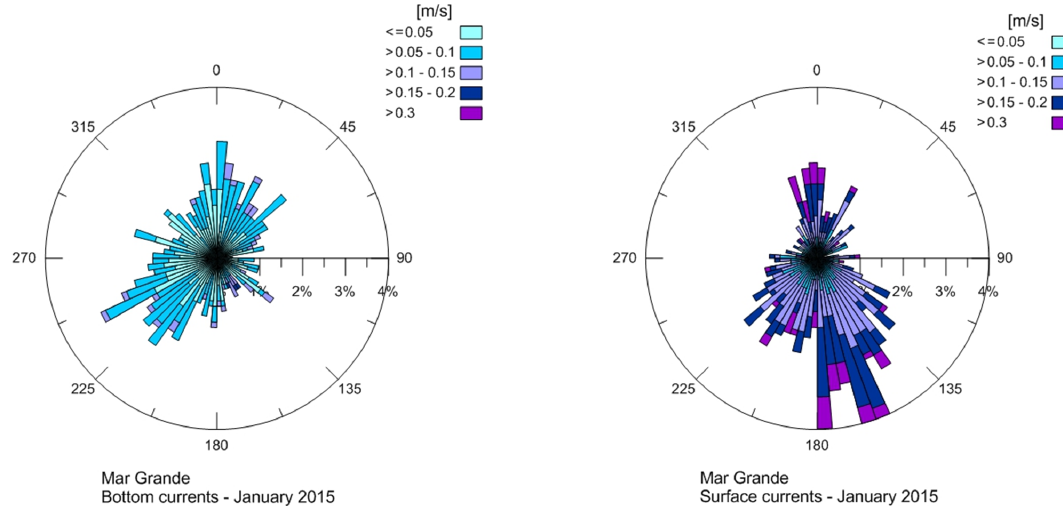
Figure 3. Polar plot of measured bottom and surface currents in January 2015 (direction of propagation shown).